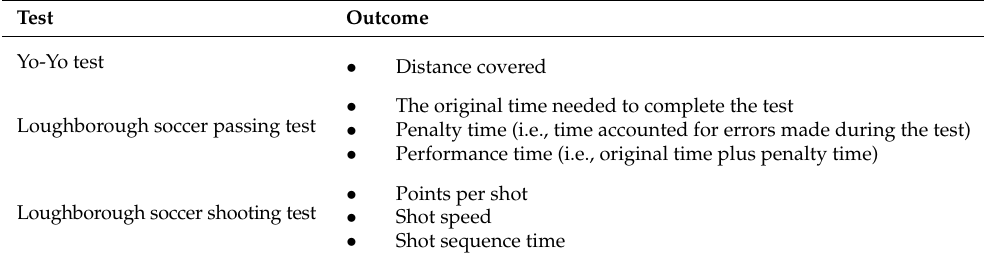
Table 1. Summary of the main outcomes in the three analyzed